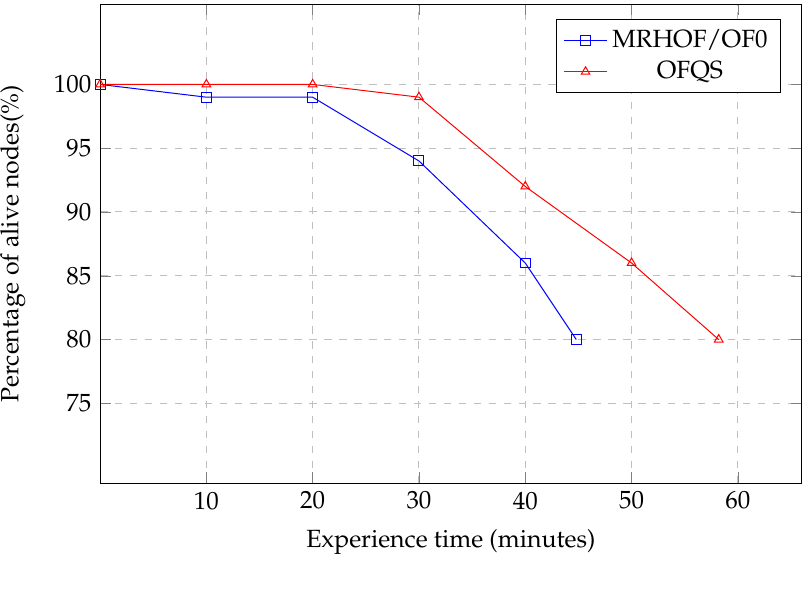
Figure 8. Network lifetime variation.